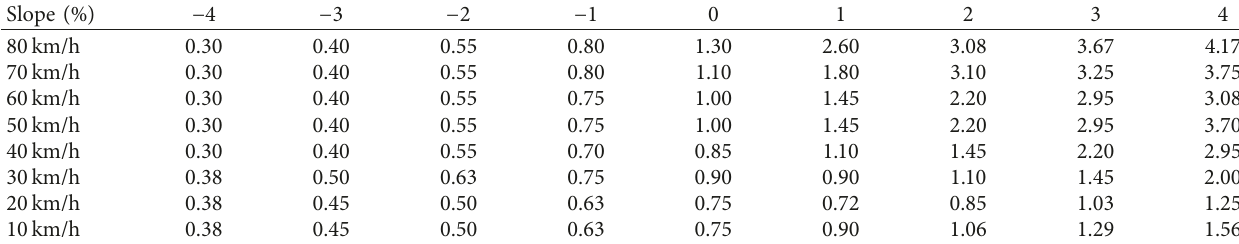
Table 4: Y � f / f related with slope percentages and driving speeds. iv ( VI ) iv ( CO )